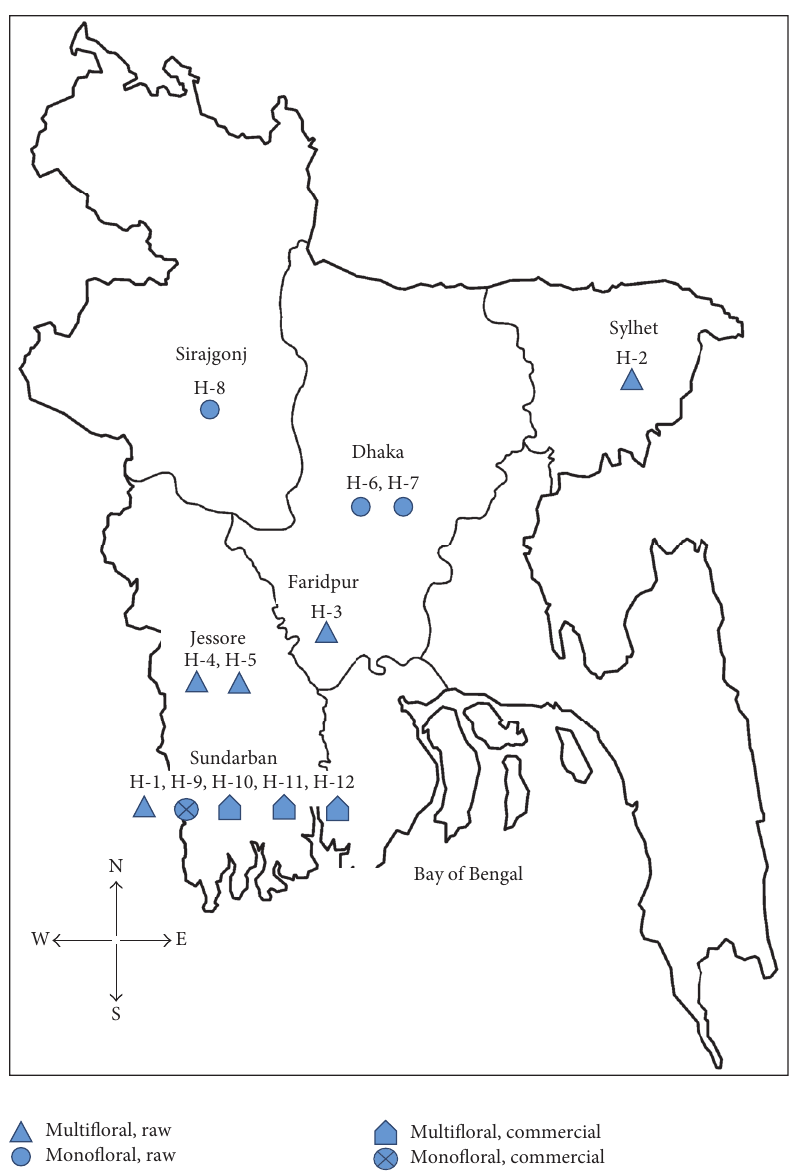
Figure 1: Geological locations of honey samples collected in this